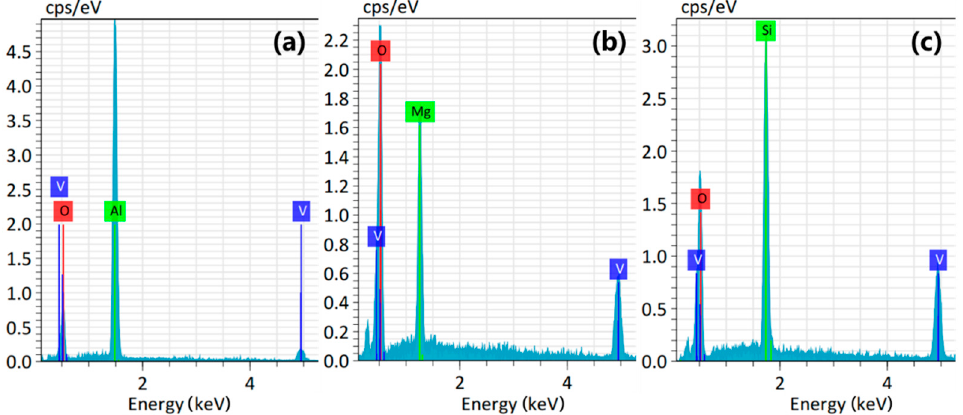
Figure 5. Energy-dispersive X-ray spectrometer (EDS) patterns of V 2 O 5 films on ( a ) Al 2 O 3 substrate; Figure 5. Energy ‐ dispersive X ‐ ray spectrometer (EDS) patterns of V 2 O 5 films on ( a ) Al 2 O 3 substrate; ( b ) MgO substrate; ( c ) SiO 2 substrate. ( b ) MgO substrate; ( c ) SiO 2